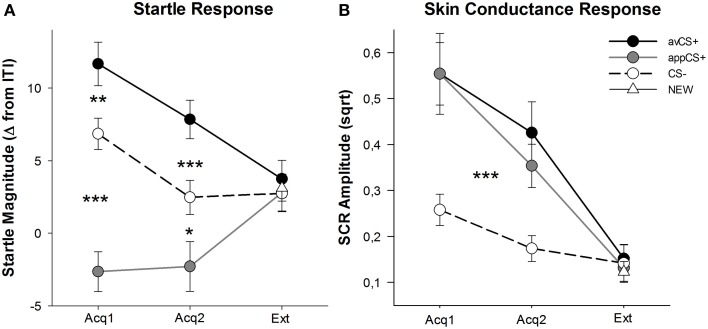
Startle responses (A) and skin conductance (B) (with standard errors) during the first acquisition phase (Acq1), the second acquisition phase (Acq2), and the extinction phase (Ext). Startle responses were significantly potentiated to the aversive CS+ (black solid line) and significantly attenuated to the appetitive CS+ (gray solid line) as compared to the CS– (black dashed line) during the acquisition phases. SCR was significantly greater to the avCS+ and the appCS+ compared to the CS–. No differences were revealed during the extinction phase. *p < 0.05, **p > 0.01, ***p < 0.001.